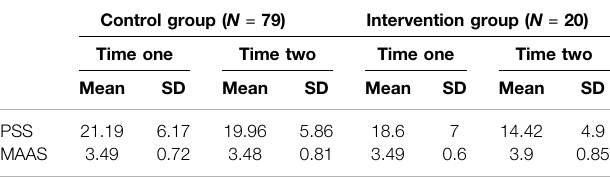
TABLE 9 | Summary of the Control Group and Intervention Group Mean Scores for the PSS and MAAS . Control group ( N = 79)